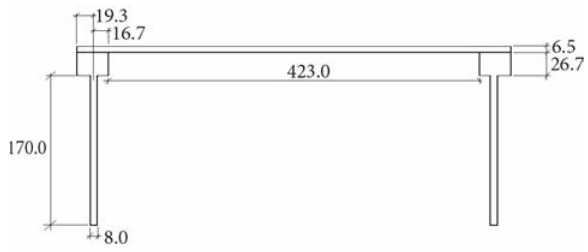
Fig. 3. Elevated view of a skewed integral bridge (in